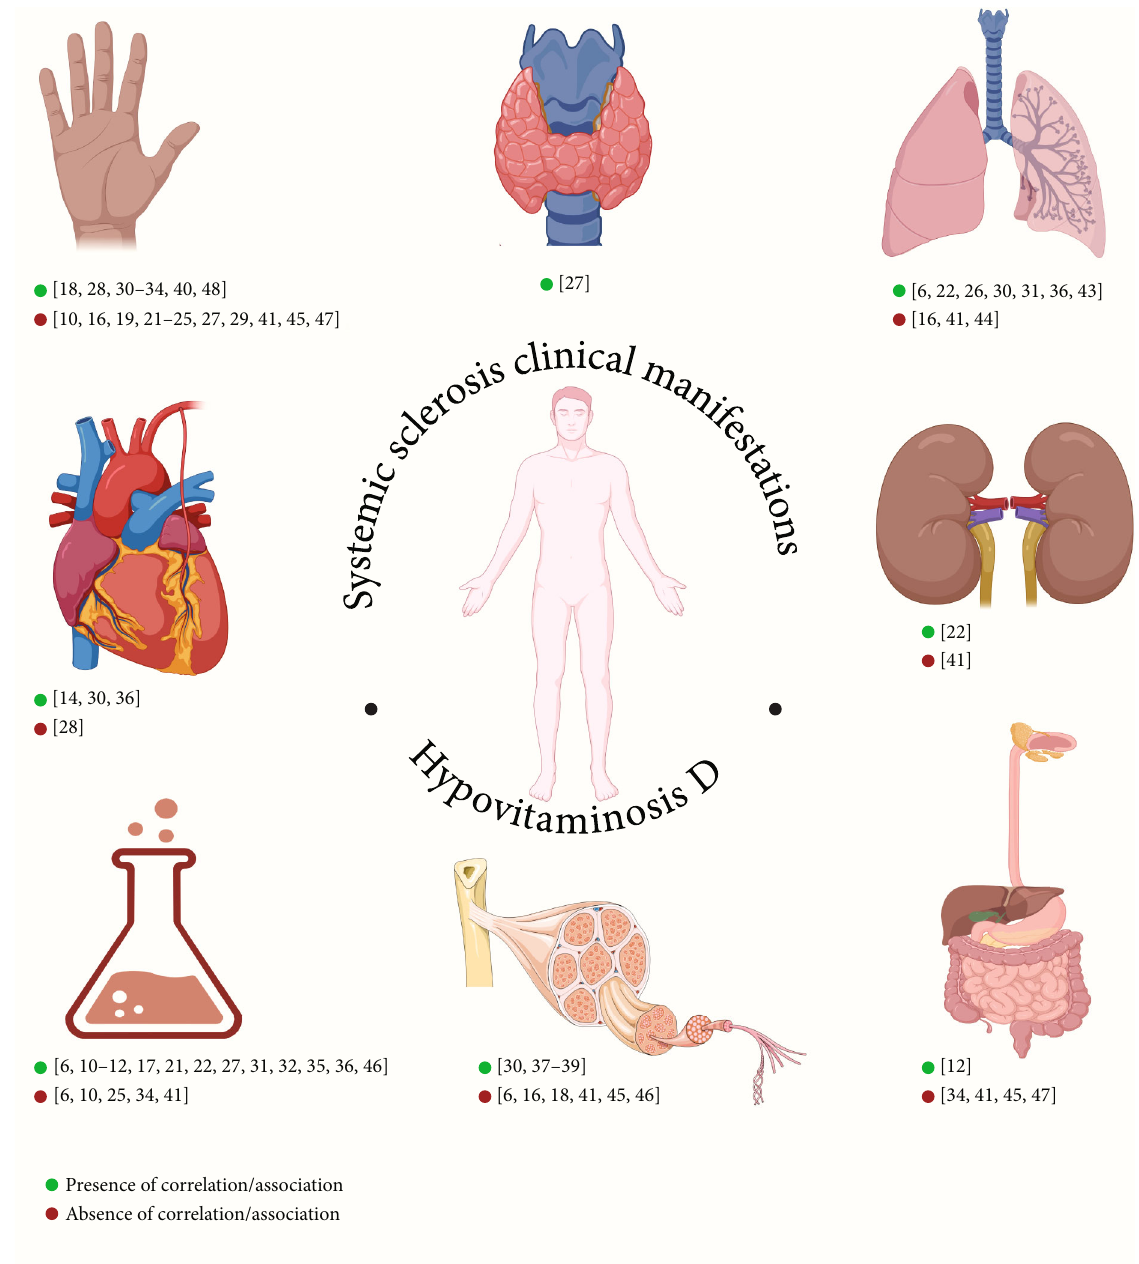
Figure 2: Relationship between systemic sclerosis clinical manifestations and hypovitaminosis